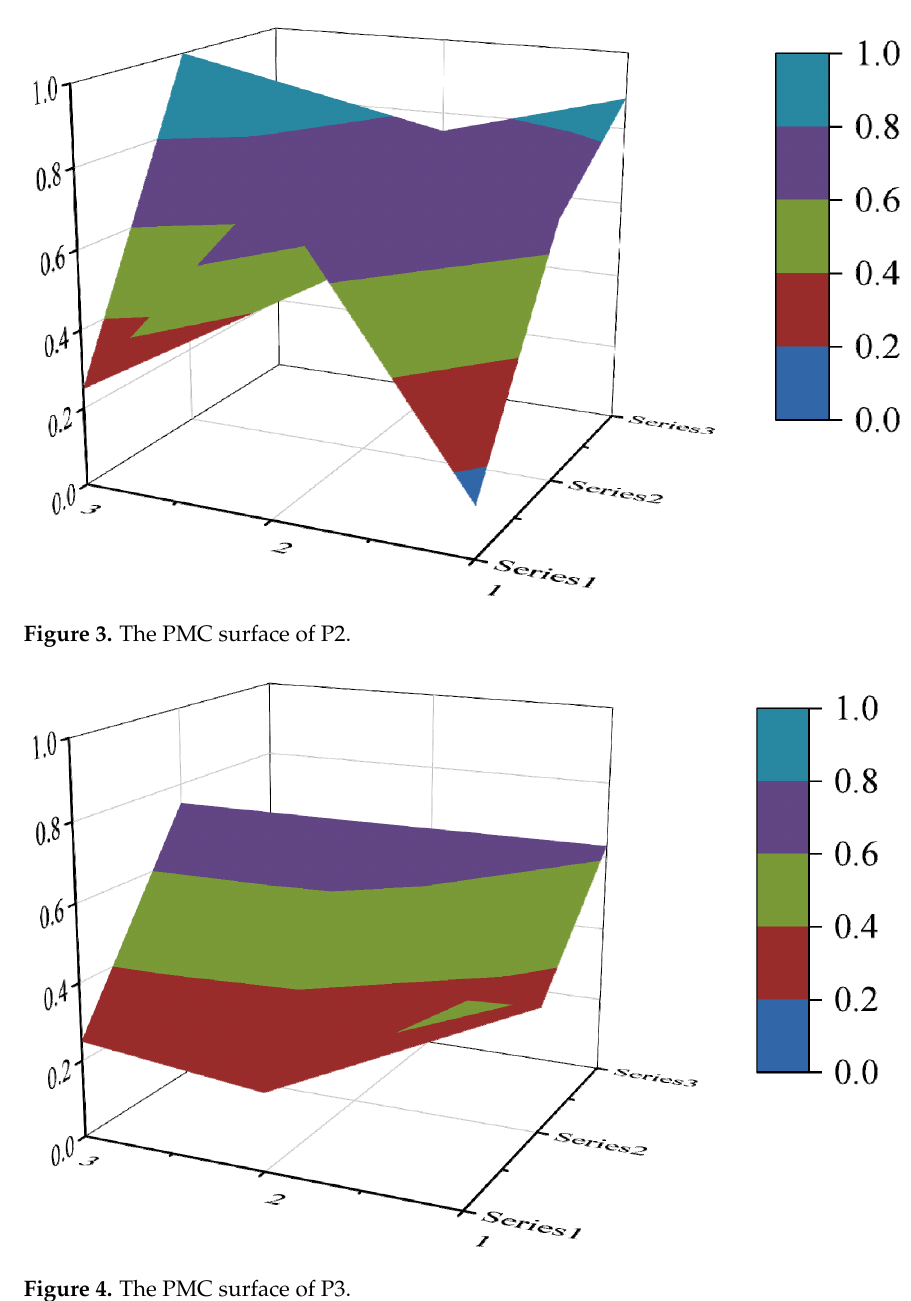
Figure 2. The PMC surface of P1.